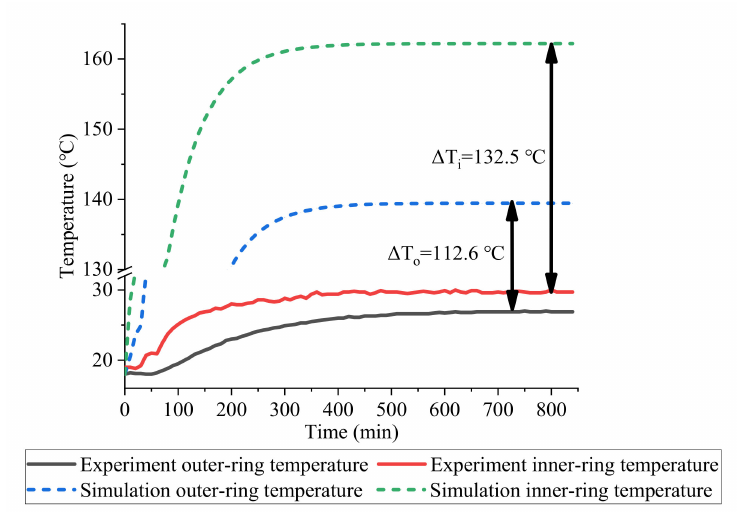
Figure 3. Temperature contrast curve between the durability experiment and the transient temperature field